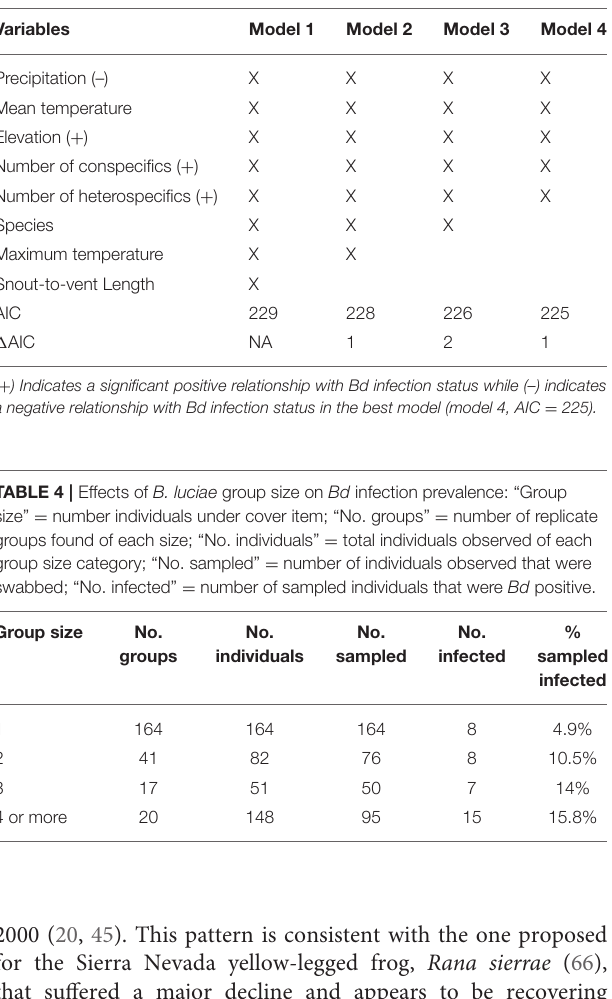
FIGURE 3 | Results of Batrachoseps luciae Bd susceptibility trial [four treatment groups; wild-strain (WS) lab-inoculated ( n = 8; dotted line), wild-strain (WS) field infected ( n = 10; dashed line), GPL (global panzootic lineage) lab-inoculated ( n = 8; solid line), and uninfected control group ( n = 5; dash and dot line)] showing Kaplan-Meier survival estimate (A) illustrating proportion of individuals surviving over time, and (B) average Bd infection intensity (zoospore equivalents, log scale) over